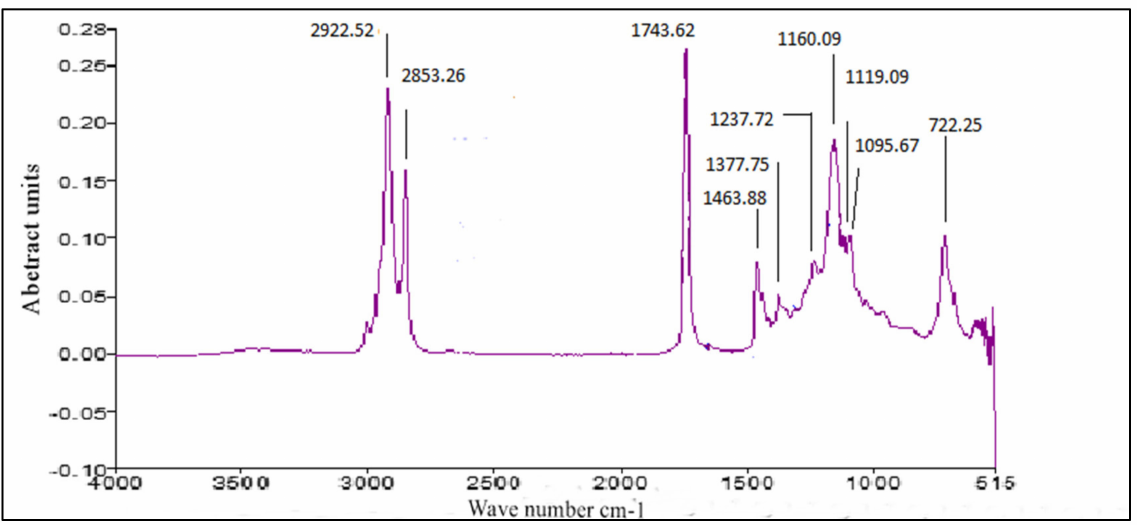
Figure 15. FT-IR analysis of PAOB by using CPC heterogenous nano-catalyst.